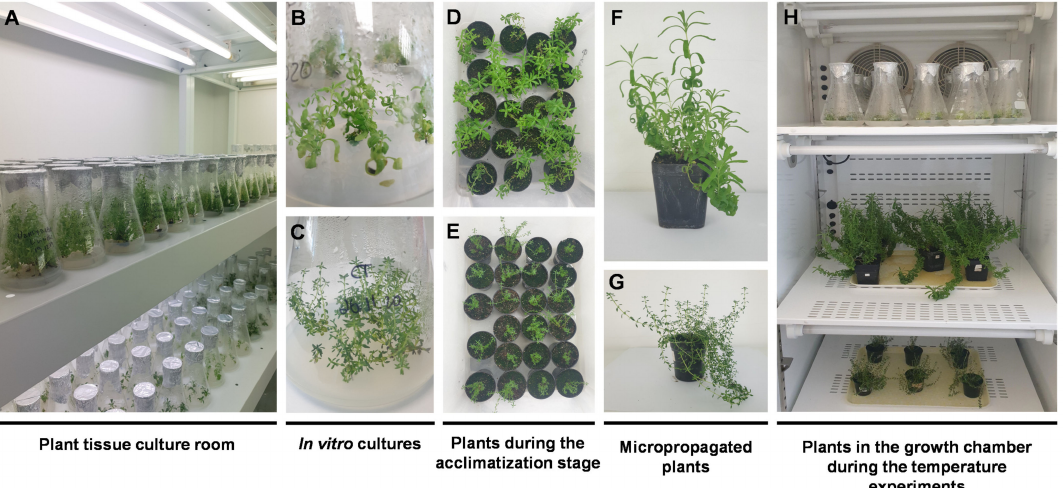
Figure 7. Plants at different stages of the micropropagation process used in the temperature experi- ments. ( A ) plant tissue culture room; ( B ) in vitro cultures of L. viridis ( C ) and T. lotocephalus ; ( D ) plants of L. viridis and ( E ) T. lotocephalus under acclimatization phase; ( F ) micropropagated plants of L. viridis and ( G ) T. lotocephalus ; ( H ) in vitro cultures and micropropagated plants of both species during the temperature experiments in a growth chamber under controlled